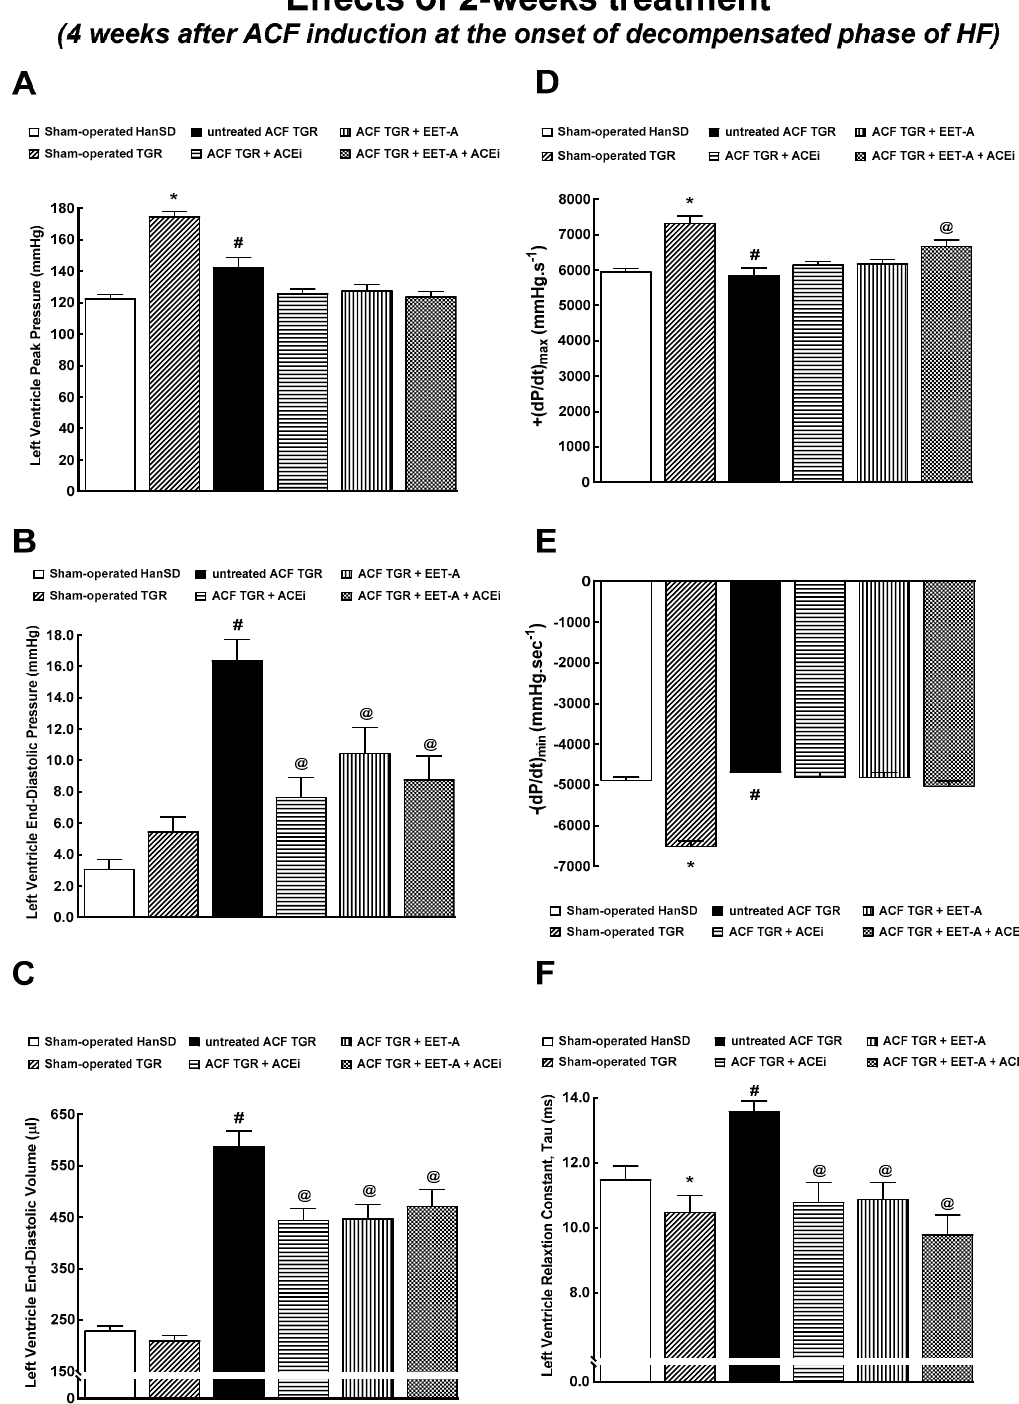
Figure 4. Part 1 of the left ventricular cardiac function assessment by invasive hemodynamic analysis performed 4 weeks after creation of the aorto-caval fistula (ACF) and 2 weeks after initiation of treatment in sham-operated transgene-negative Hannover Sprague-Dawley rats (HanSD), sham-operated heterozygous Ren-2 transgenic rats (TGR) and TGR rats with ACF, untreated or treated with angiotensin-converting enzyme inhibitor (ACEi) alone or with 14,15-epoxyeicosatrienoic acid analog (EET-A) alone or with the combination of EET-A and ACEi. Left ventricle peak pressure ( A ), left ventricle end-diastolic pressure ( B ), left ventricle end-diastolic volume ( C ), maximum rates of pressure rise (+dP/dt) max ( D ), maximum rates of pressure fall (-dP/dt) max ( E ), relaxation constant tau ( F ). * p < 0.05 sham-operated TGR versus sham-operated HanSD rats. # p < 0.05 for untreated ACF TGR versus sham-operated TGR. @ p < 0.05 versus untreated ACF TGR.